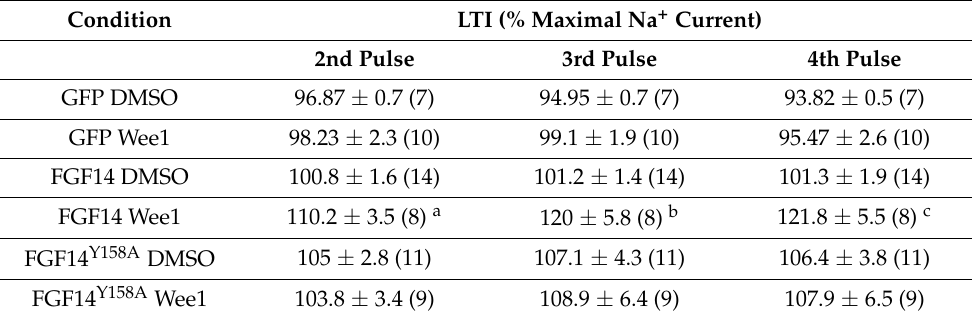
Table 2. Effects of pharmacological inhibition of Wee1 kinase on the entry of Na v 1.2 channels into long-term inactivation †